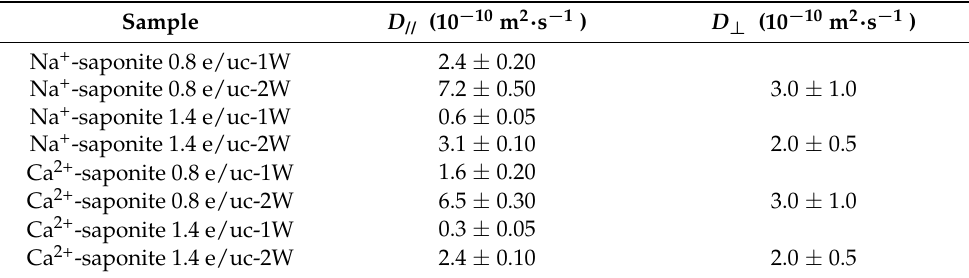
Table 1. Water dynamical parameters, D // and D ⊥ , respectively, the self-diffusion coefficient defined in the direction parallel and perpendicular to the clay surface, deduced from MD simulations for all samples investigated at 300 K. The data are from Table 3 in the Ref. [28] with permission from Ref. [28]. Copyright (2012) American Chemical